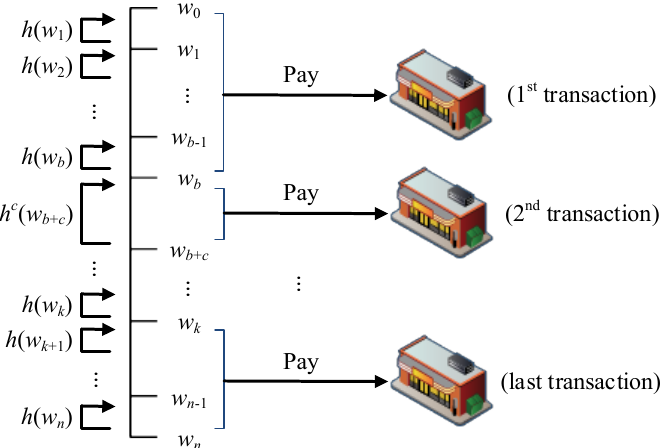
Figure 3. Simple offline transaction credit splitting